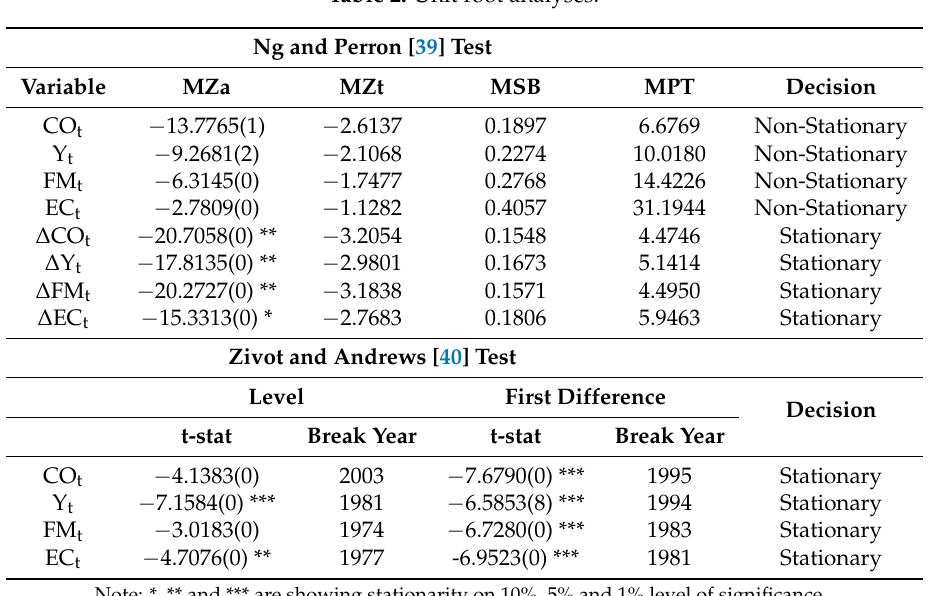
Table 2. Unit root